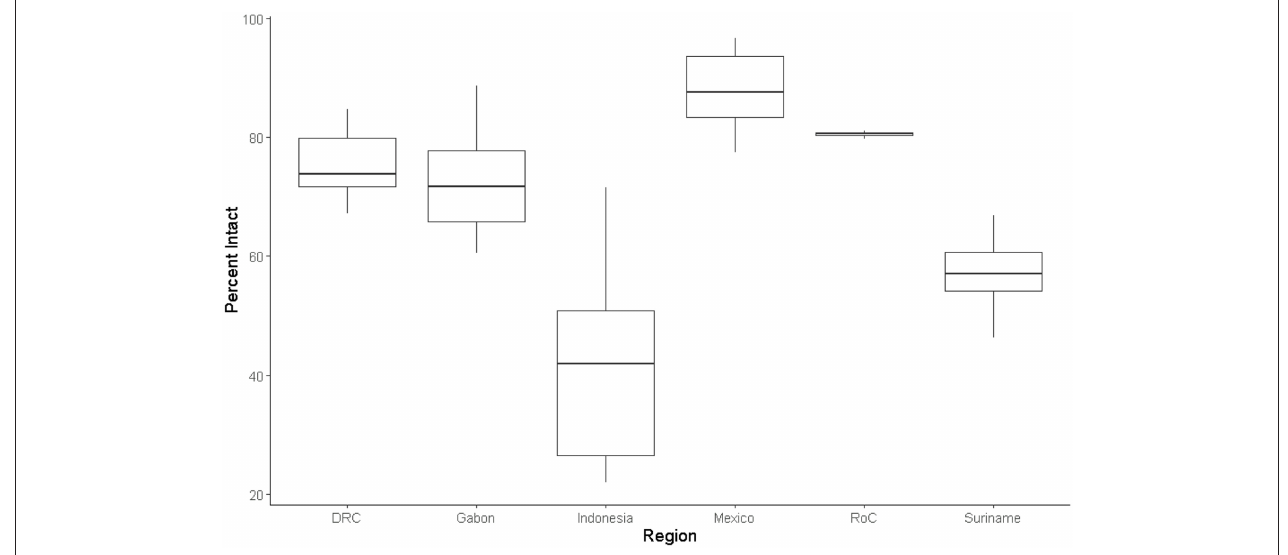
FIGURE 2 | Proportions of intact forest in selectively logged harvest blocks (DRC, Democratic Republic of Congo; RoC, Republic of Congo).